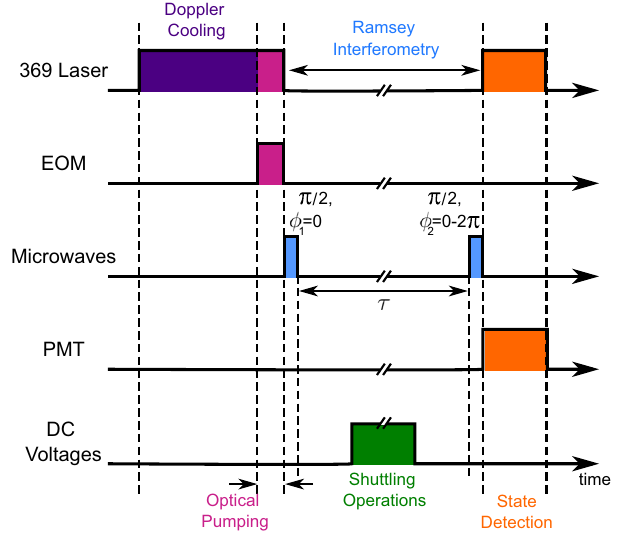
Fig. 5 | Pulse sequence diagram for the Ramsey-type experiment. The relative times of the different processes are represented on the same time axis (not to scale). From the top down the axes are: the on/off times for the 369.5nm Doppler cooling laser, the electro-optic modulator (EOM) for optical pumping, the microwaves reso- nantwiththequbittransition,thePMTfordetectionandtheDCsystemforshuttling.